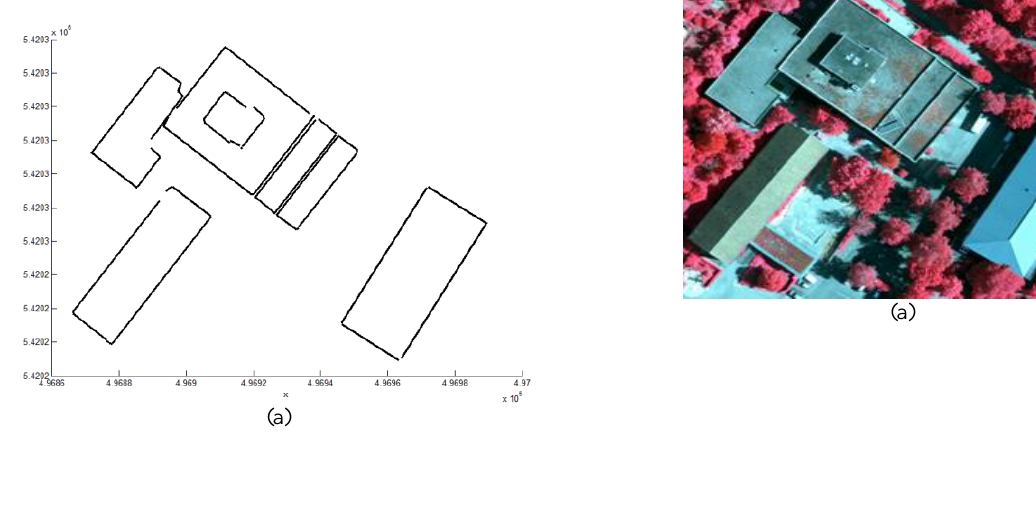
Figure 6. Convex (1) and non-convex (2) line segments After Classification of edge points, a RANSAC method is separately applied on each classified edge-points group. For non-convex lines segment the process must be repeated until all lines are extracted. After applying the RANSAC algorithm, primary lines are generated (cf. Figure 7a). For accessing final lines, regularization constraints must be performed. The main regularization constraints are: (1) removal of the small lines, (2) forcing approximately parallel lines to being exactly parallel by turning around weighted azimuth average, (3) merging of lines close to each other, (4) connecting two consecutive parallel lines with an orthogonal line and (5) intersection of crossover lines. In buildings with tilted roofs, segments buildings are intersect to reconstruction of internal lines. Results are shown in Figure 7b.